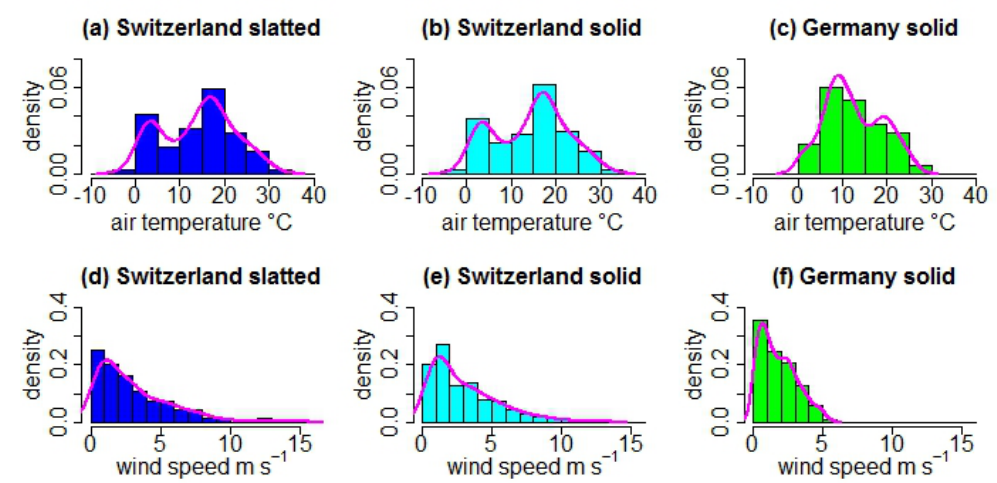
Figure 2. Histograms showing the density distributions of air temperature (upper row) and wind speed (lower row) in the three data sets: ( a , d ) compartment with slatted floor at Swiss farm, ( b , e ) compartment with solid floor at Swiss farm, and ( c , f ) building with solid floor at German farm. Breaks were set from − 10 to 40 in steps of 5 for the binning of the temperature data and from 0 to 16 in steps of 1 for the binning of the wind data.